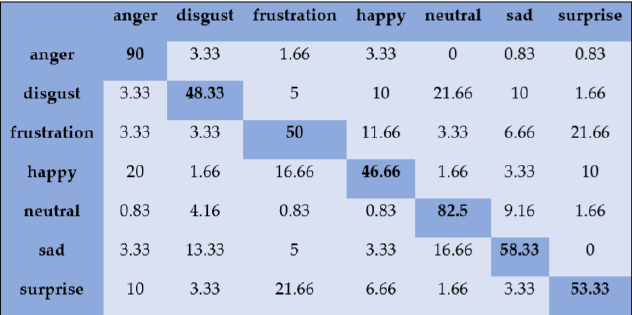
Figure 7. Confusion matrix of- SAVEE dataset for speaker-independent